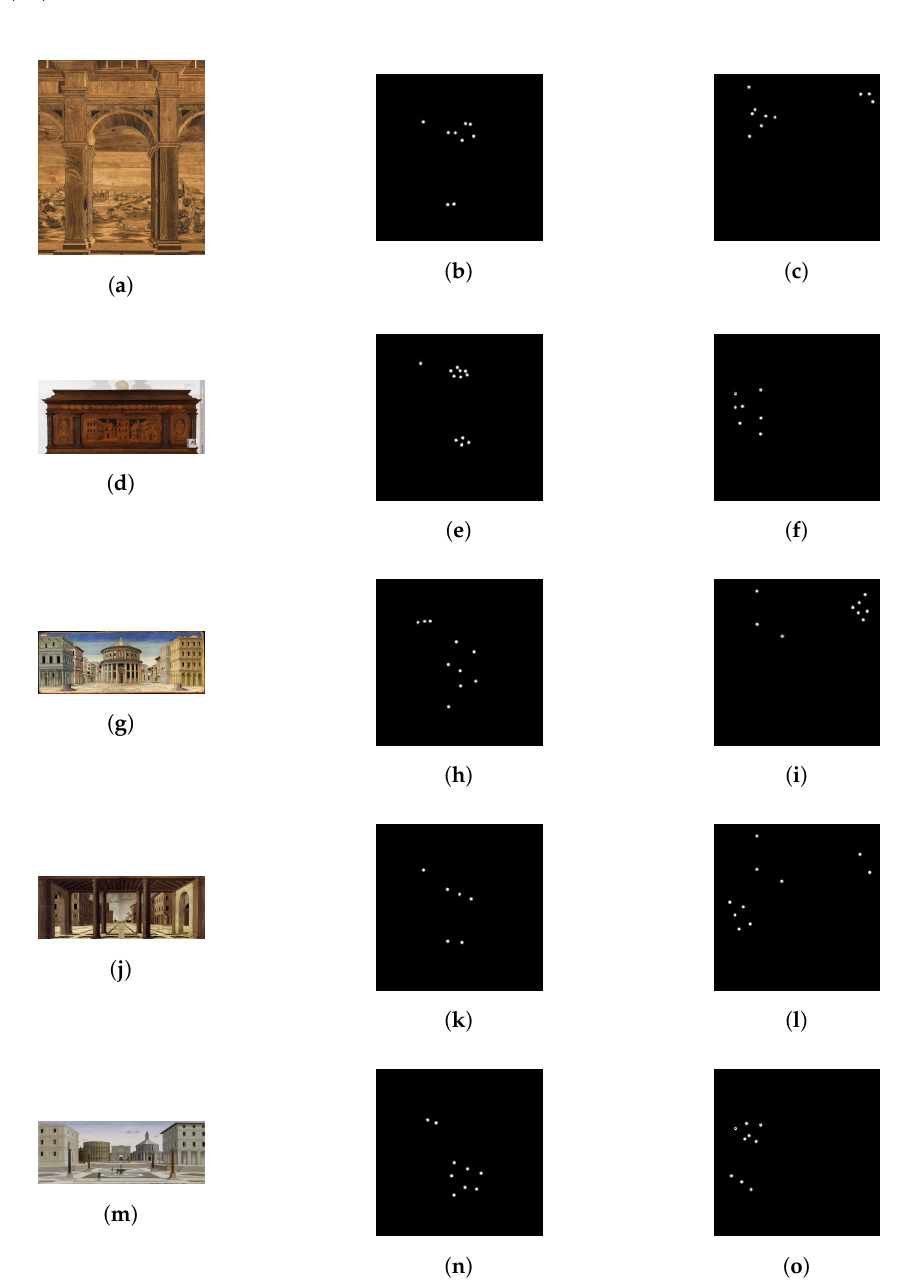
Figure 5. Resulting images after coordinates view transformation. The first column shows the stimulus images; the second column depicts an example of the images generated for the Adult class; the third column reports an example image generated after the coordinates view transformation for the children